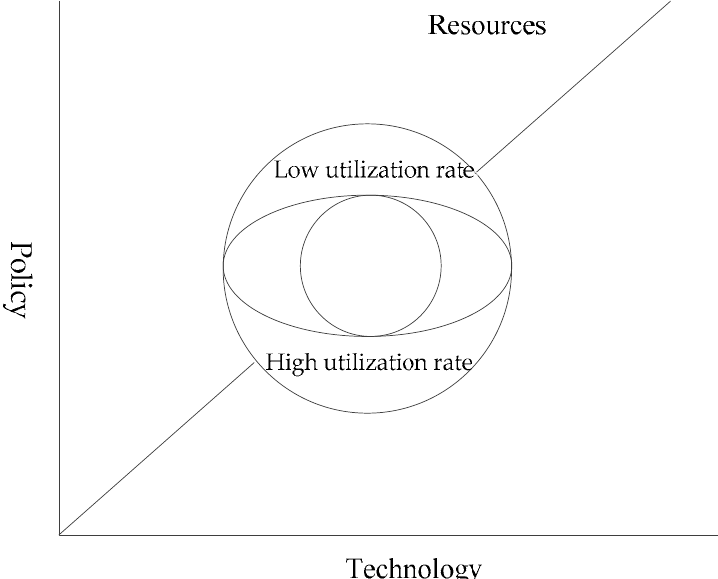
Figure 4. Hypervolume model of the ecological niche of photovoltaic agriculture.